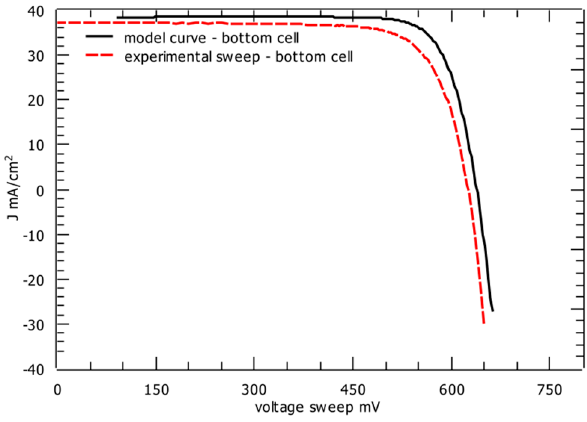
Table 1. Experimental J-V fit parameters for the c-Si subcell.